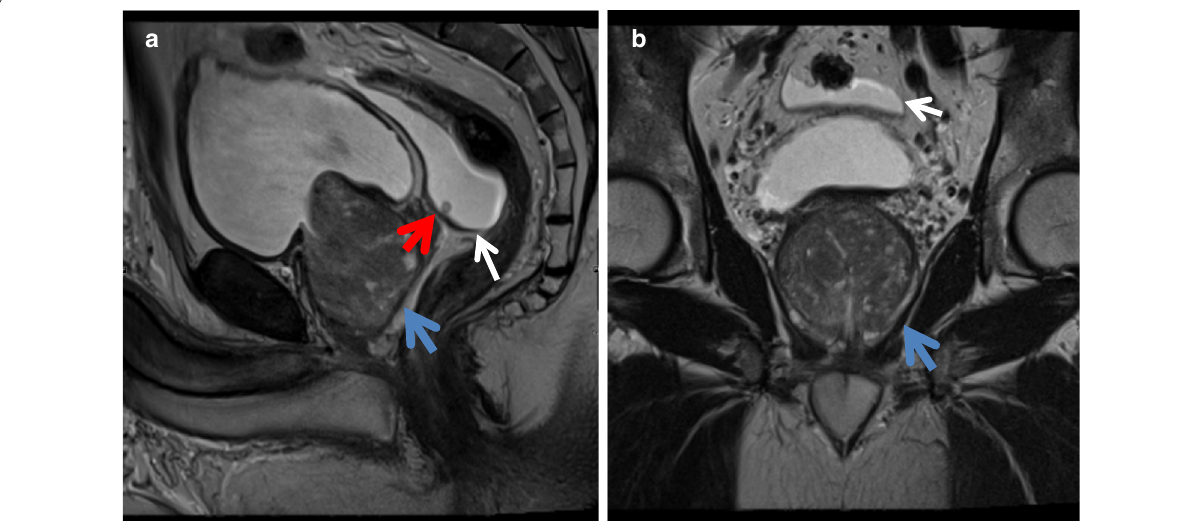
Fig. 21 Ascites a Sagittal and b coronal T2-weighted images demonstrate high T2 signal free fluid (white arrows) of similar intensity to the urinary bladder in keeping with ascites. The fluid is seen posterior and superior to the prostate (blue arrow) at the base of the bladder. a Also shows a 4 mm nodule (red arrow) in the anterior inferior aspect of the free